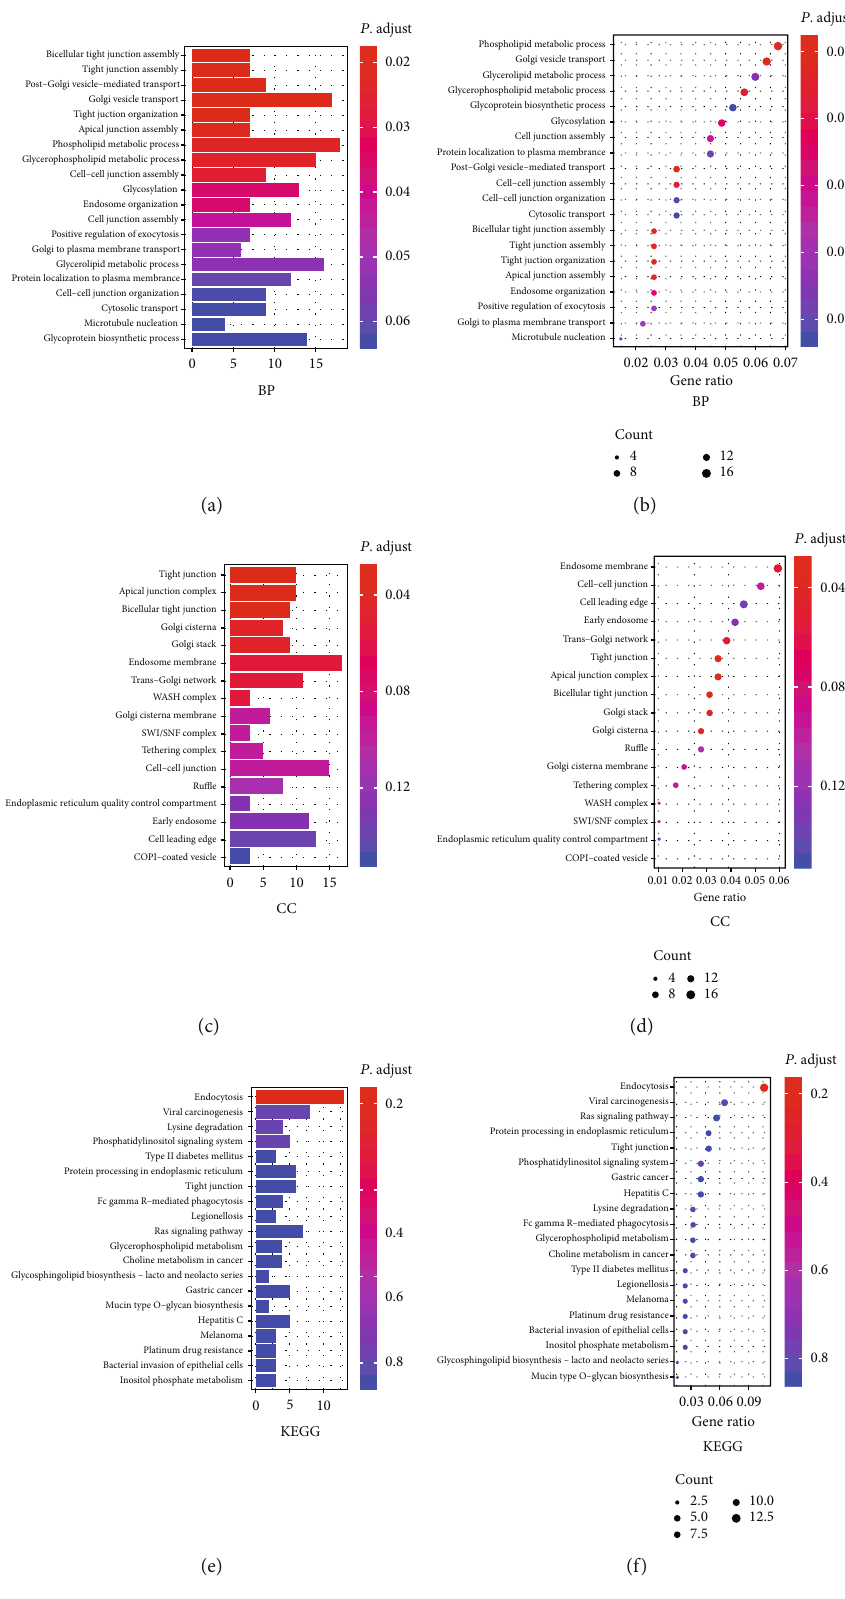
Figure 5: GO enrichment analysis of genes coexpressed with KLF5 in rectal adenocarcinoma. (a, b) Bar chart or bubble chart in biological process (BP) category. (c, d) Bar chart or bubble chart in cell component (CC) category. (e, f) KEGG enrichment analysis of genes coexpressed with KLF5 in rectal